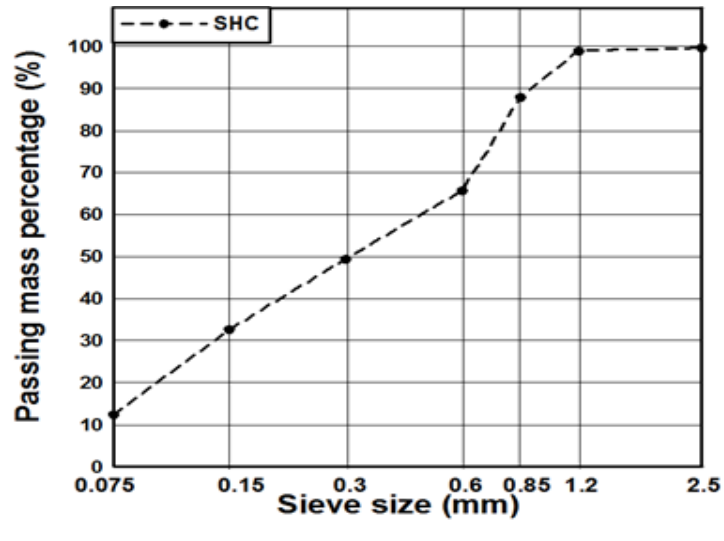
Figure 2. Size and range of self-healing solid capsules.